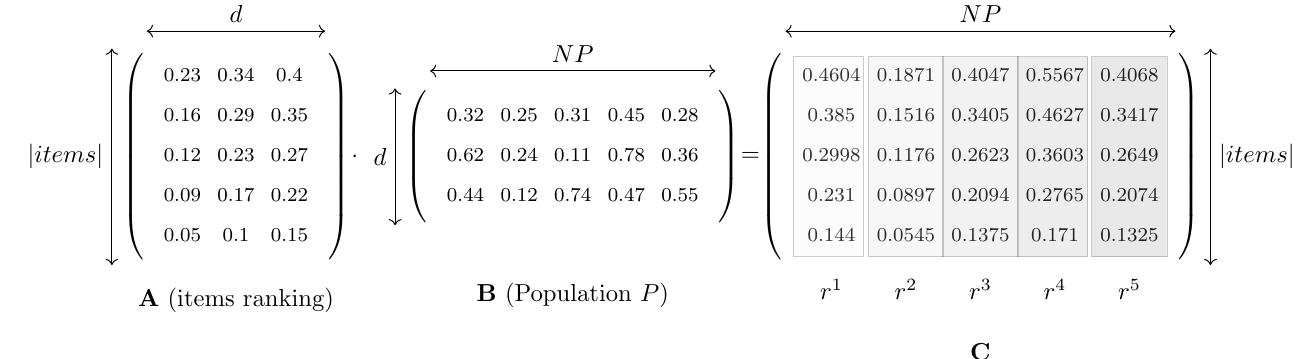
Figure 1. Toy example of the multiplication of two matrices. Matrix A represents scores assigned by the recommendation algorithms to each item i metaheuristic algorithm represented by matrix B . Matrix product C represents new scores for each I , which, after sorting, create new rankings τ n where n item i ∈